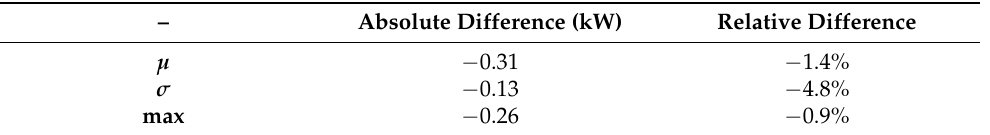
Table 9. Variation of daily peak of the grid active power demand during May 2020 between Scenario B and Scenario A. µ : average value, σ : standard deviation, max: maximum value.